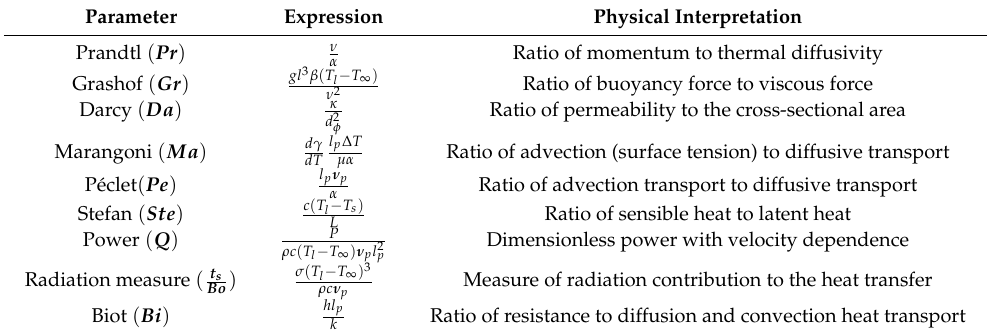
Table 2. Symbols, expressions and their physical interpretation for the dimensionless quantities considered in Equations (4) and